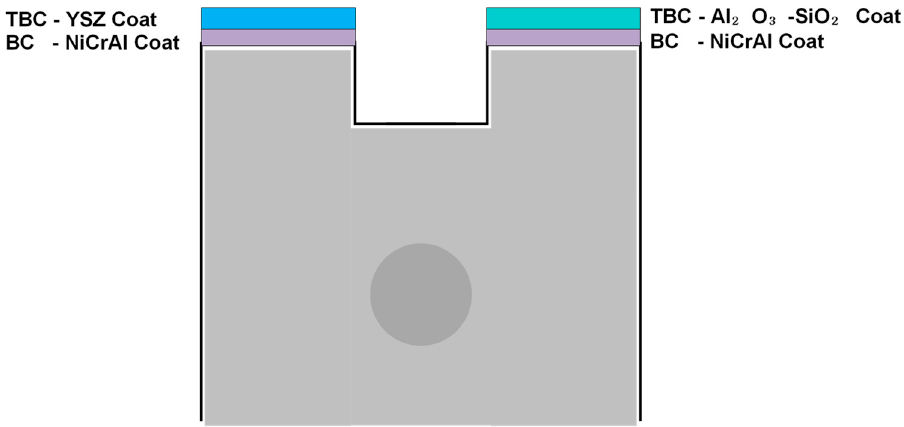
Figure 3. Thermal barrier coating layer on a piston.